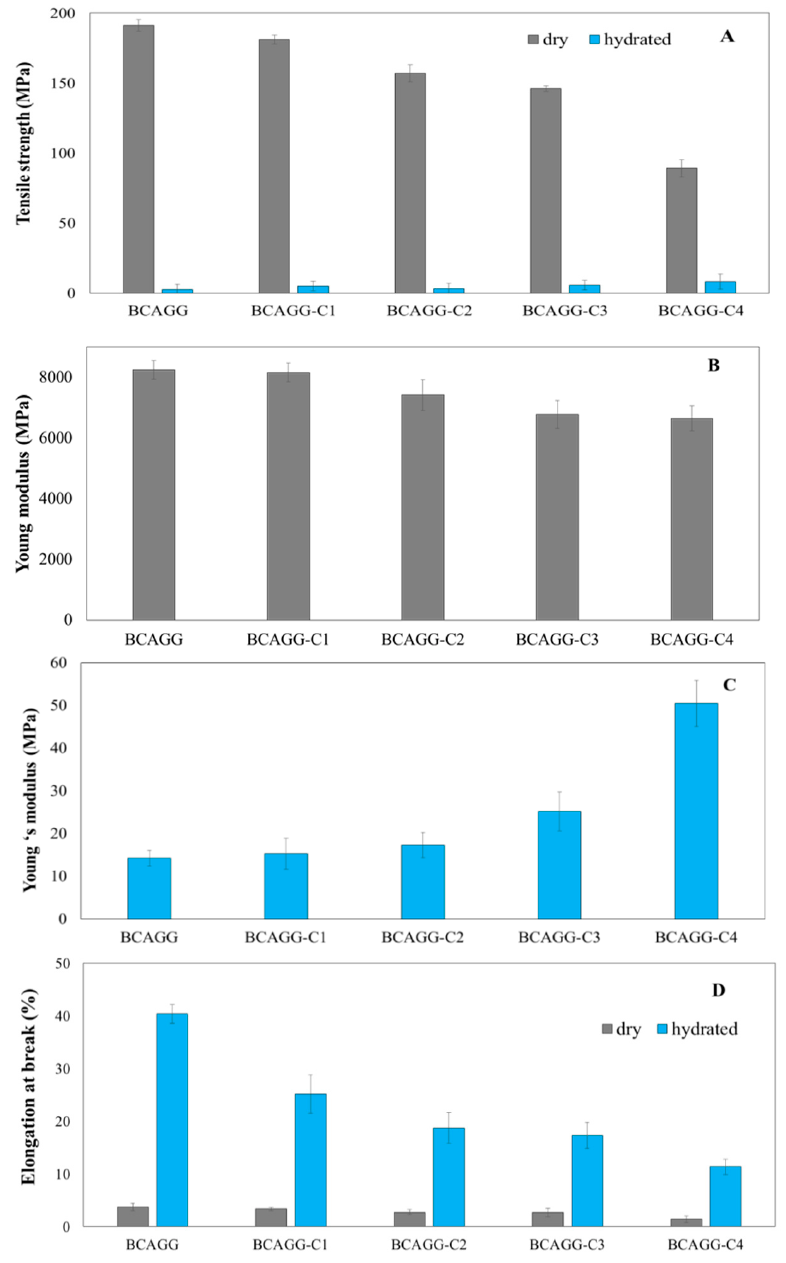
Figure 5. Mechanical properties of films: ( A ) tensile strength of dry and hydrated films; ( B ) Young’s modulus of dry films; ( C ) Young’s modulus of hydrated films; and ( D ) elongation at break (%) of dry and hydrated films.